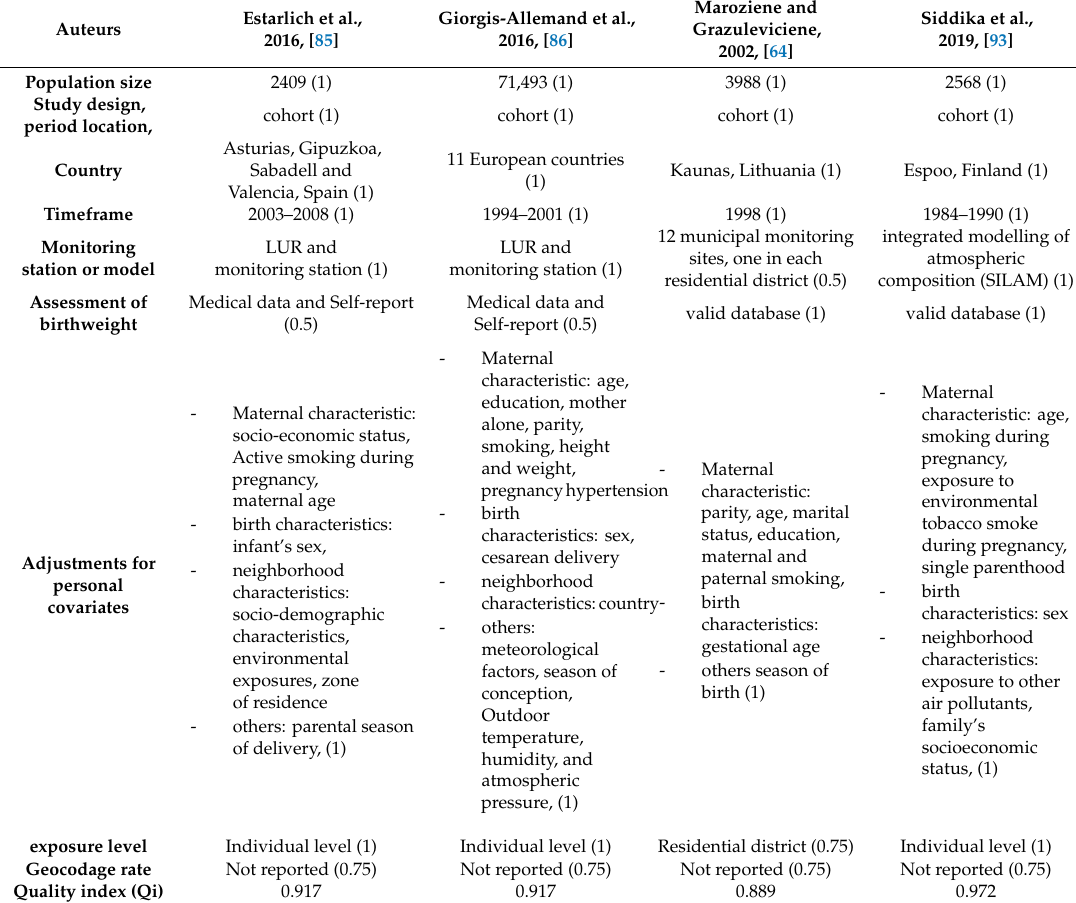
Table A4. Qualitative analysis (part